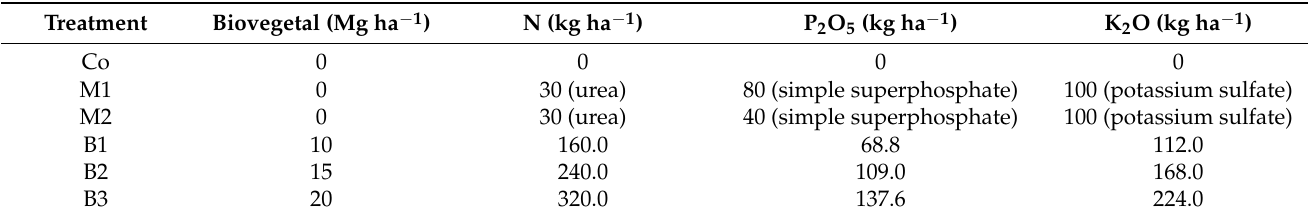
Table 2. Fertilization conditions applied to desi (cv Senise) and kabuli (cv Sultano) chickpeas.